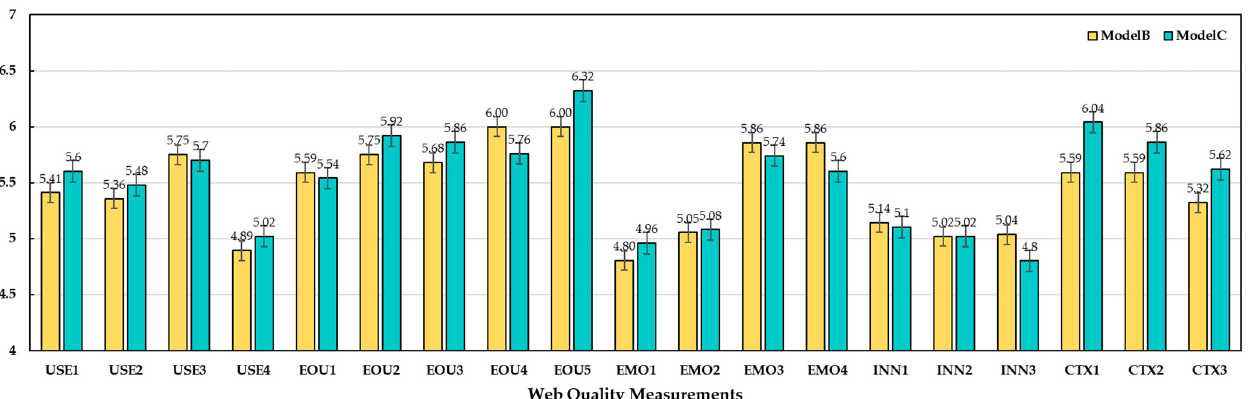
Electronics 2022 , 11 , 1445